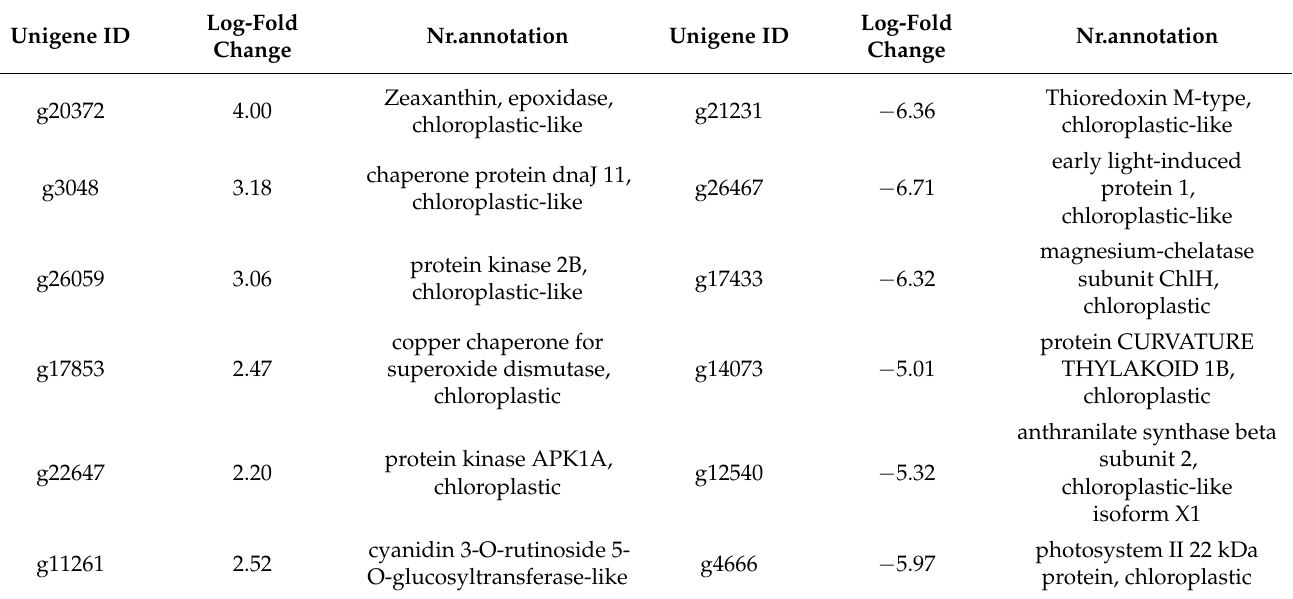
Table 4. Chloroplast genes affected by UV-B